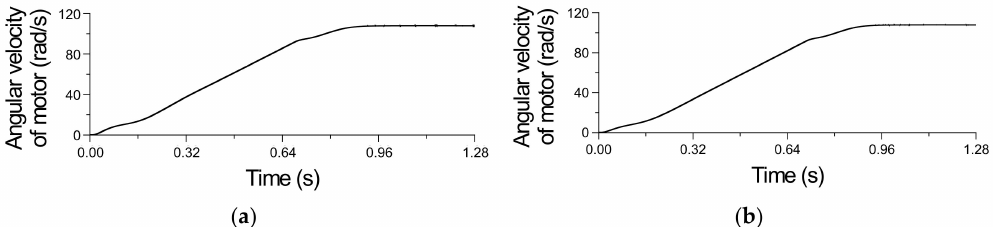
Figure 13. Waveforms of the angular velocity of the motor in the control system shown in Figure 7 with a linear ( a ) and non-linear ( b ) torque limit controller during motor